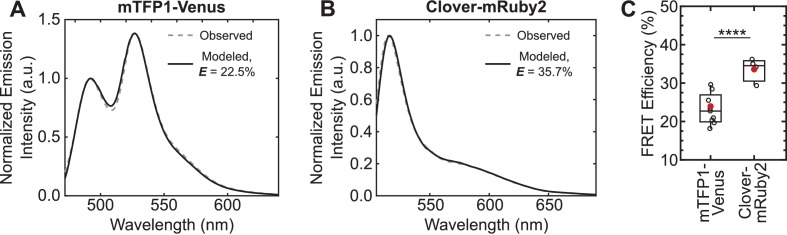
Increase in unloaded FRET efficiency with Clover-mRuby2 sensors in vitro.(A, B) Representative images of quantitative spectral analysis of mTFP1-Venus (A) and Clover-mRuby2 (B) TSMod fluorescence in cell lysates using the (ratio)A method (Majumdar et al., 2005). (C) Quantification of unloaded FRET efficiency for mTFP1-Venus and Clover-mRuby2 TSMods with (GPGGA)8 extensible domain; (n = 9 and 4 independent experiments, respectively); red filled circle denotes sample mean; ****p<0.0001, Student’s t-test, two-tailed, assuming unequal variances.10.7554/eLife.33927.007Figure 1—figure supplement 2—source data 1.Fluorometric FRET measurements.